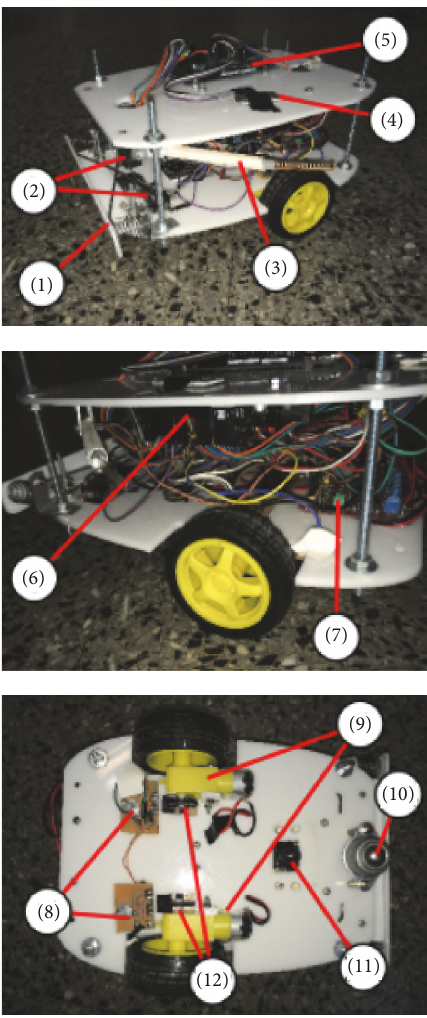
Figure 5: Constitutive parts of robot: (1) bumper, (2) bumper sensors (switches), (3) tilt sensor, (4) Bluetooth module, (5) Arduino Due board number 1 (this implements the GCs, i.e., (3), (4), and (5)), (6) Arduino Due board number 2 (this implements the trajectory tracking as proposed in [16]), (7) motor driver L298N [19], (8) photodetector, (9) wheels and motors (gears are fixed to wheels), (10) small freewheel, (11) color camera TTL OV5642 [17], and (12) slotted